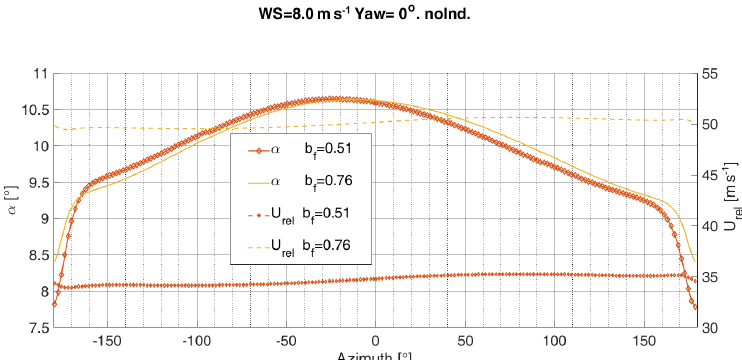
Figure 4. α and U rel for two blade stations (denoted in the legend by their spanwise fractions b f ) as a function of ψ under aligned conditions and a steady hub-height wind speed of 8ms − 1 as calculated by AD15.